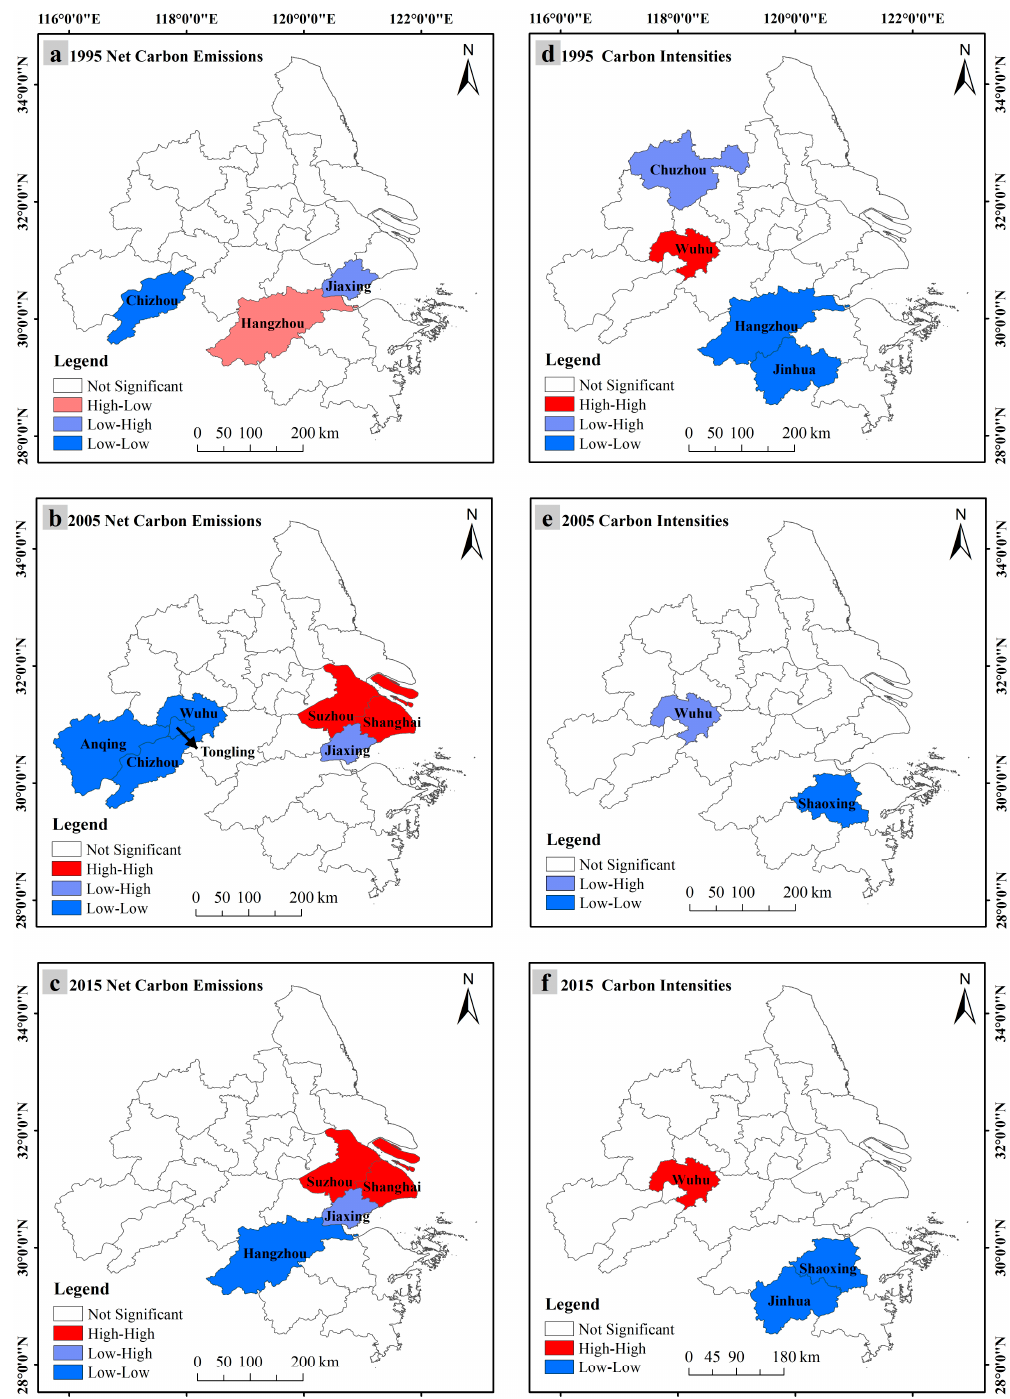
Figure 9. LISA cluster maps of net carbon emissions ( a – c ) and carbon intensities ( d – f ) for the YRDUA in 1995, 2005, and